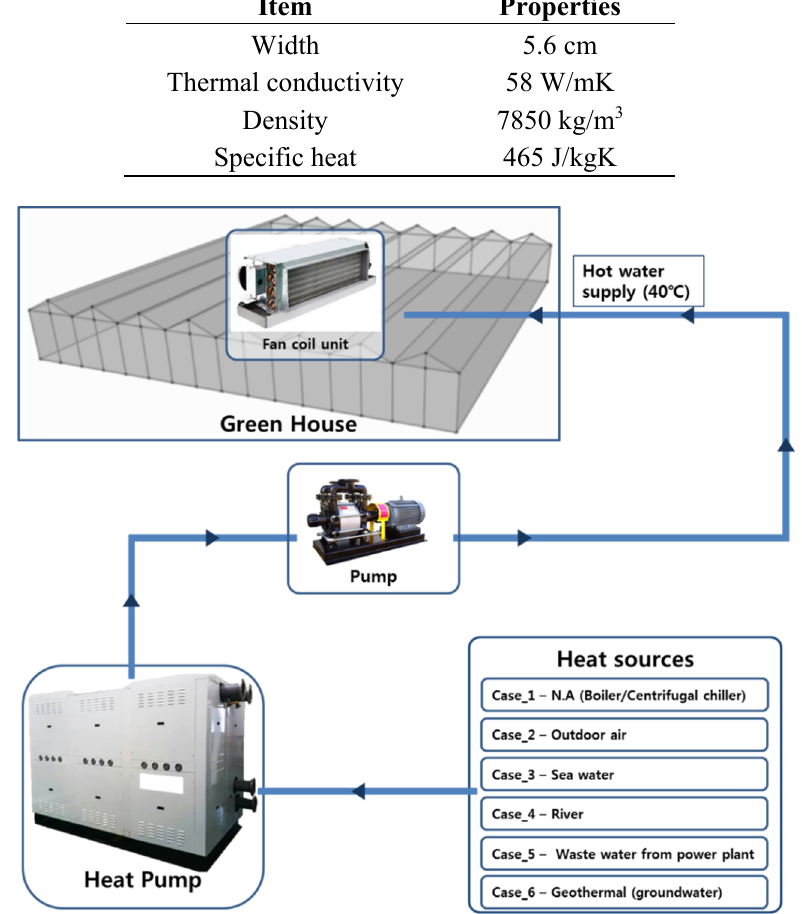
Figure 2. Schematic diagram of the simulated